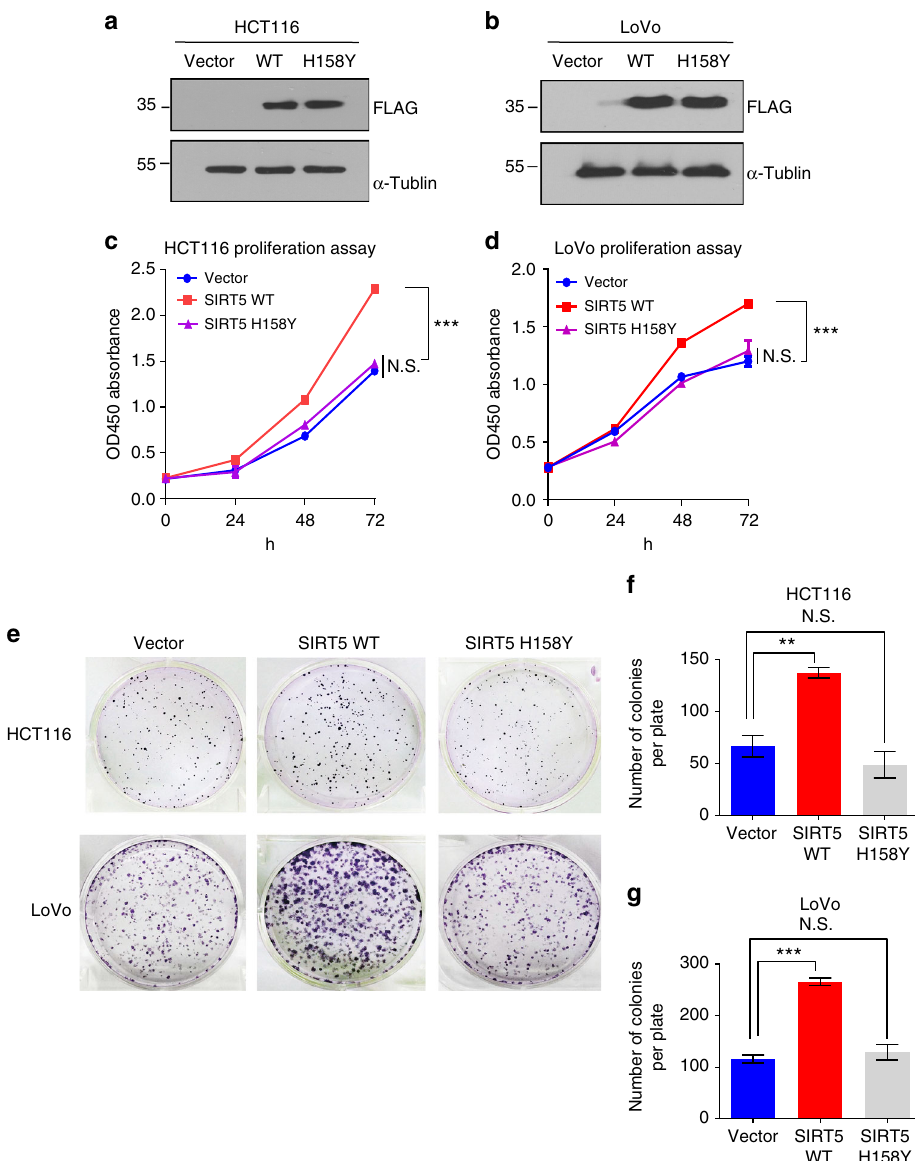
Fig. 3 SIRT5 promotes colorectal cancer cell growth dependent on its catalytic activity. a , b Western blotting con fi rming the stable expression of the control vector, FLAG-SIRT5 WT, or FLAG-SIRT5 H158Y in HCT116 ( a ) and LoVo ( b ) cells. c , d Growth curve of HCT116 ( c ) and LoVo ( d ) cells stably expressing the control vector (blue line), SIRT5 WT (red line), or SIRT5 H158Y (purple line). Data are the mean ± SD of fi ve independent samples. ANOVA with Tukey ’ s test. *** P < 0.001. N.S. = not signi fi cant for the indicated comparison. e Representative wells of the clonogenic growth experiment of HCT116 and LoVo cells stably expressing the control vector, SIRT5 WT, or SIRT5 H158Y, respectively. f , g Quanti fi ed data of the clonogenic growth experiment in HCT116 ( f ) and LoVo( g ) cells. Data are the mean ± SD of three independent samples. P values were calculated by ANOVA with Tukey ’ s test. ** P < 0.01 and *** P